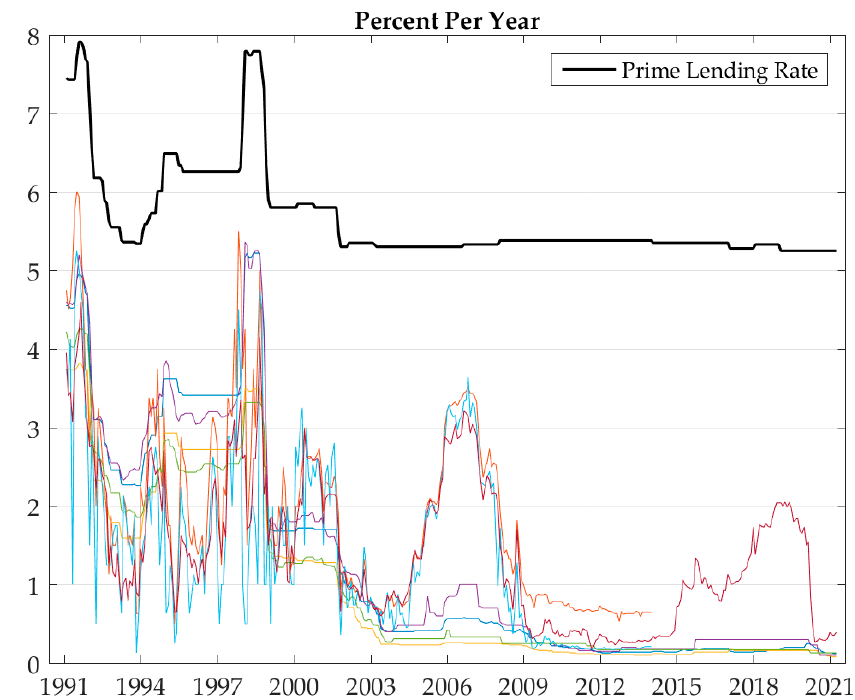
Figure 1. Benchmark rate versus other interest rates.